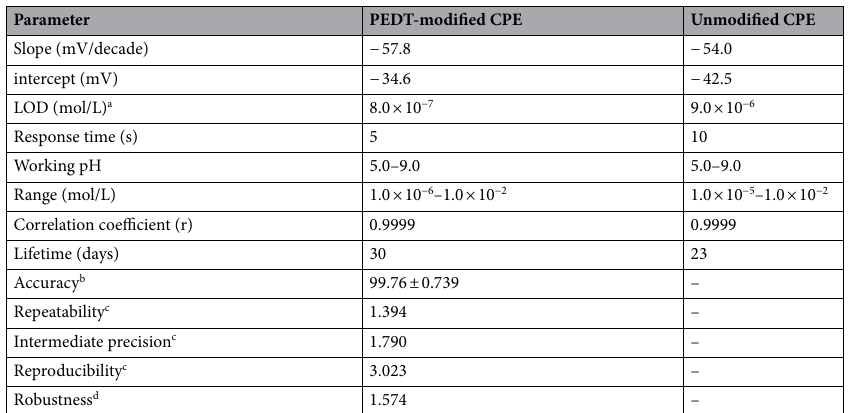
Table 1. Electrochemical response characteristics of the proposed PRO electrodes. a Detection limit was estimated by interception of the extrapolated arms of calibration curves. b Mean ± SD of recoveries for five determinations. c RSD% of recoveries for the determination of three concentrations (1.0 × 10 −5 , 1.0 × 10 −4 and 1.0 × 10 −3 mol/L), repeated three times within the day for repeatability, repeated in three successive days for intermediate precision and measured using three different electrodes for reproducibility ( n = 9). d RSD% of recoveries for the determination of two concentrations (1.0 × 10 −4 and 1.0 × 10 −3 mol/L) measured at three different buffer pH values of 6.5, 7.0 and 7.5 ( n = 6).